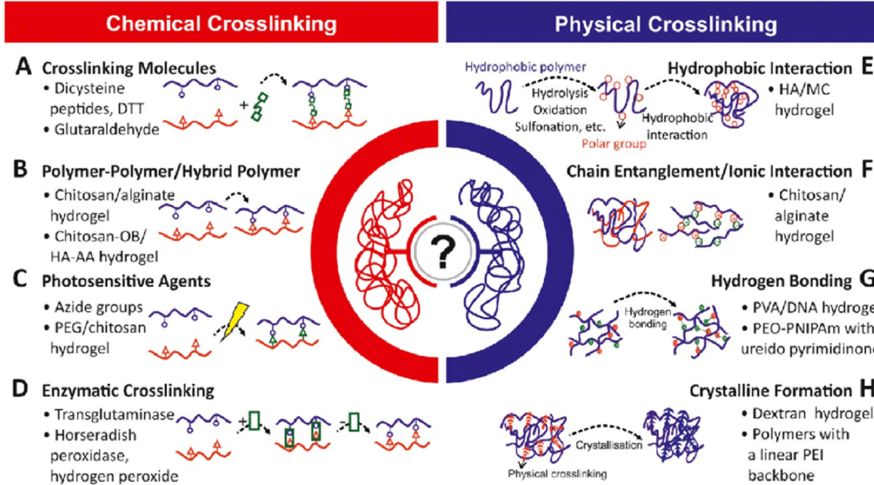
Figure 5. Polymers and crosslinking physico-chemistry. Reprinted with permission from ref. [22].